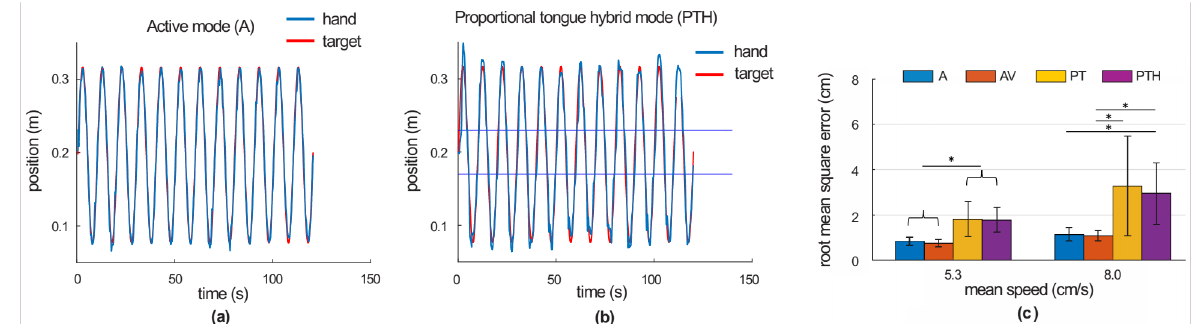
Figure 3. Tracking task performance outcome (RMSE) for active (A) and proportional tongue hybrid control (PTH) modes for 10 healthy participants. ( a , b ) Hand trajectories of a healthy person during target tracking using A and PTH modes (mean moving target speed 5.3 m/s). The blue and red lines are the subject’s hand and target positions, respectively, in the left-right direction. The region between the straight blue lines in ( b ) indicates the active range of motion without robot assistance. ( c ) The RMSE for four tested modes with two different target speeds calculated across 10 healthy subjects (mean ± S.D.). The asterisks show significant differences between control modes ( p < 0.05, Games Howell post-hoc